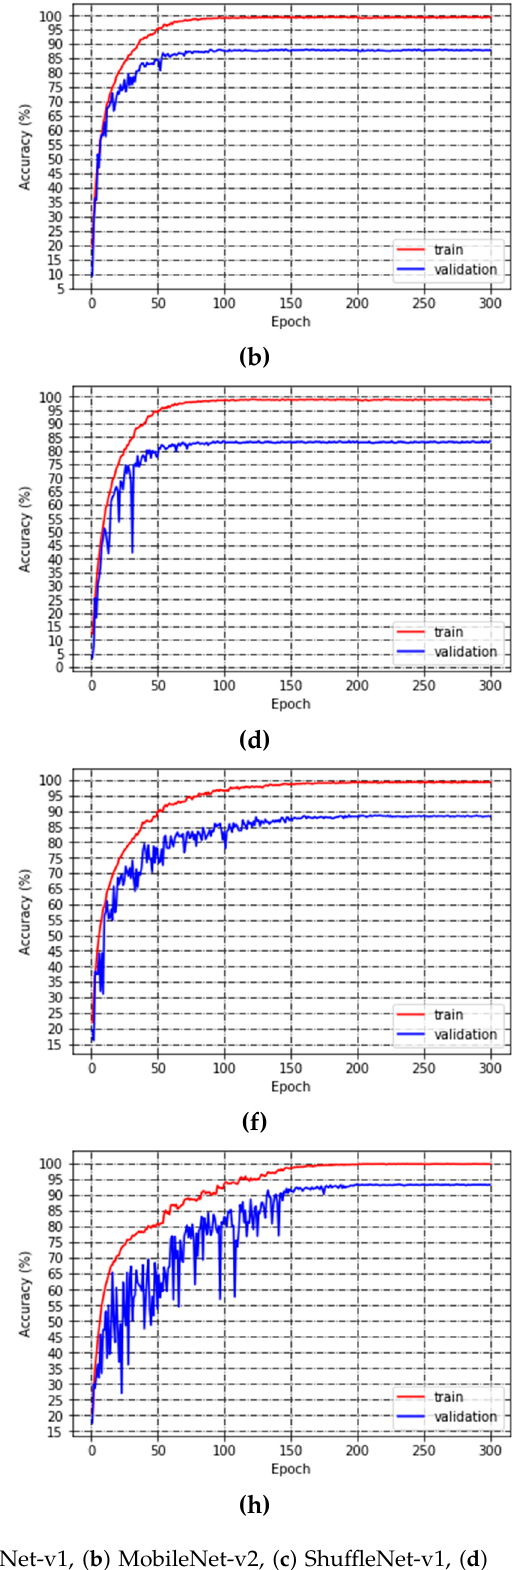
Figure 8. Training plot of each model. ( a ) MobileNet-v1, ( b ) MobileNet-v2, ( c ) Shu ffl eNet-v1, ( d ) Shu ffl eNet-v2, ( e ) NIN-16, ( f ) SENet-16, ( g ) VGG-16, ( h ) WeaklyDenseNet-16.